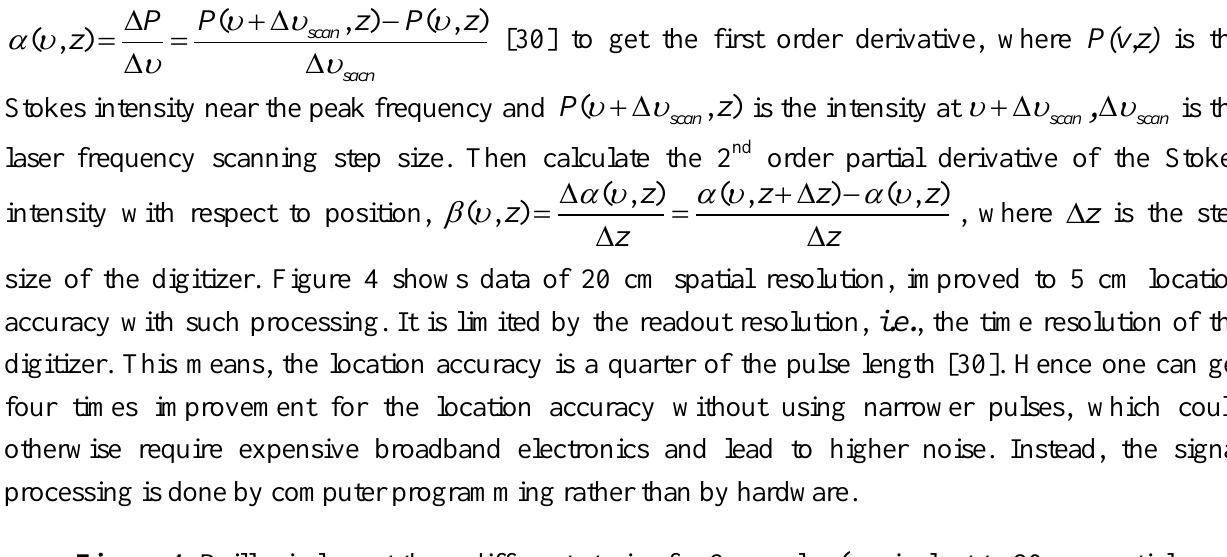
Figure 4. Brillouin loss at three different strains for 2 ns pulse (equivalent to 20 cm spatial resolution [30] (Copyright © 2005 OSA, Reprinted with